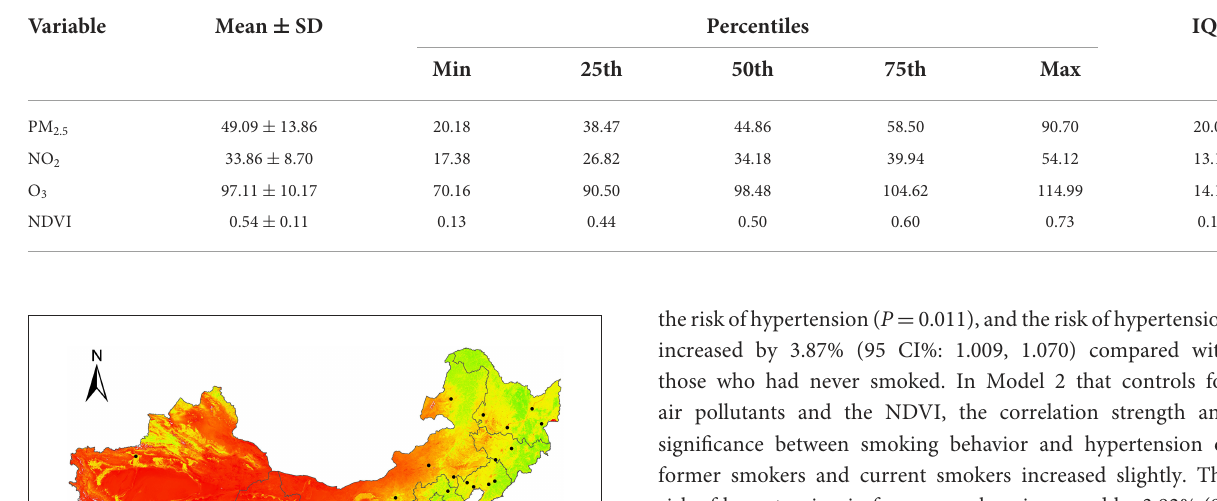
TABLE 2 Summary statistics of the air pollutants and NDVI during the study period.